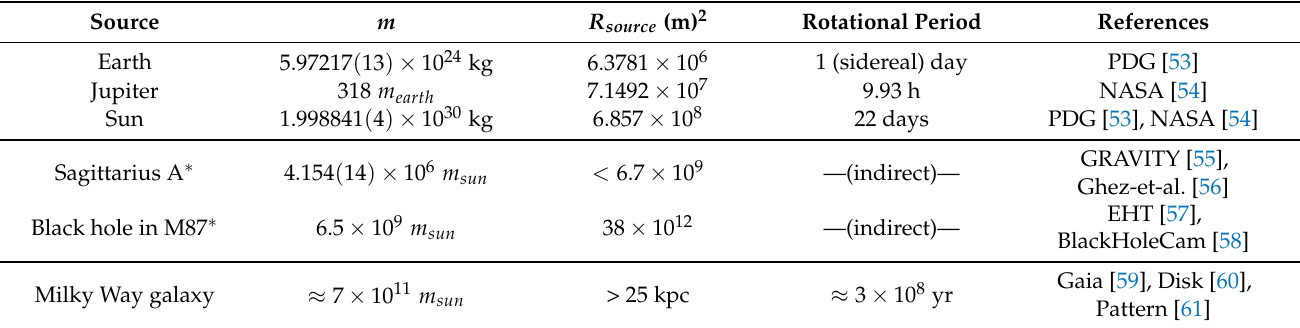
Table 1. Some observational astrophysical